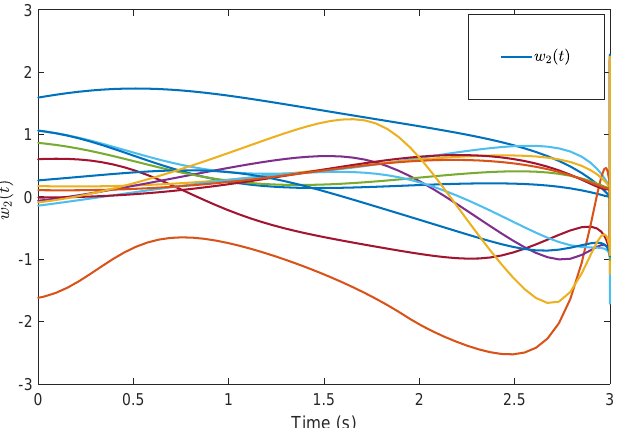
Figure 11. Intermediate states w 2 (t) by the prescribed-time Controller (62).